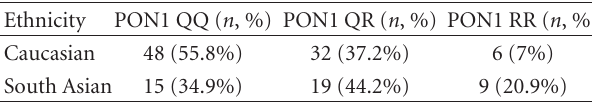
Table 2: Frequency of PON1 phenotypes by ethnicity. Ethnicity